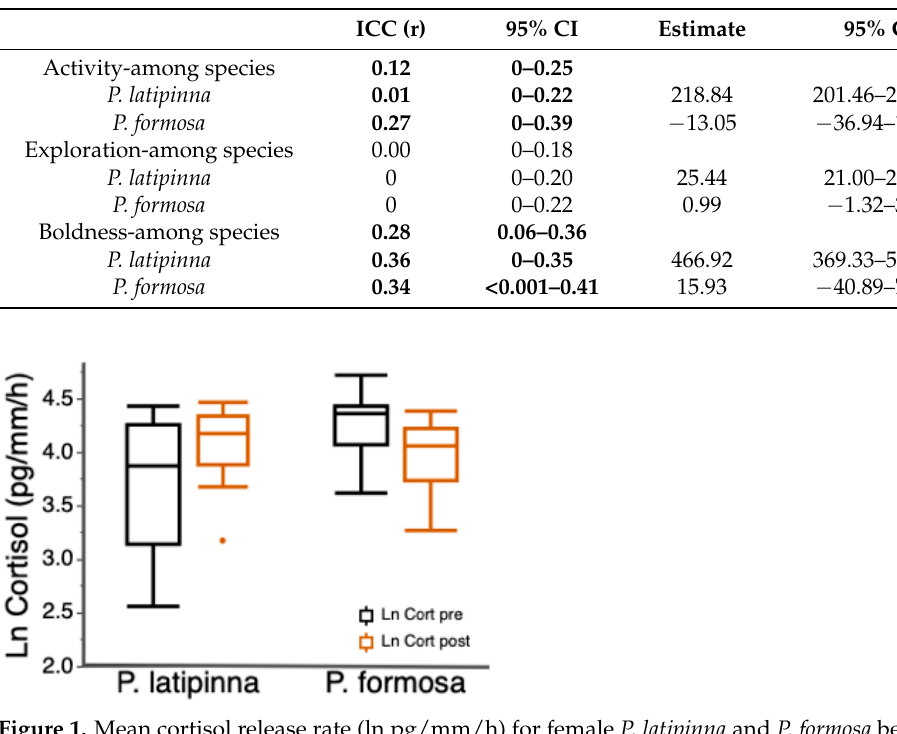
Table 1. Mixed-effects model results of repeatability of behaviors within and among Poecilia formosa and P. latipinna (Intraclass correlation coefficient (ICC) values) and comparisons between species for each behavior, both statistics include 95% confidence intervals. Behavioral estimates and 95% confidence intervals for P. formosa are the difference between P. formosa and P. latipinna . Bold values are significant.